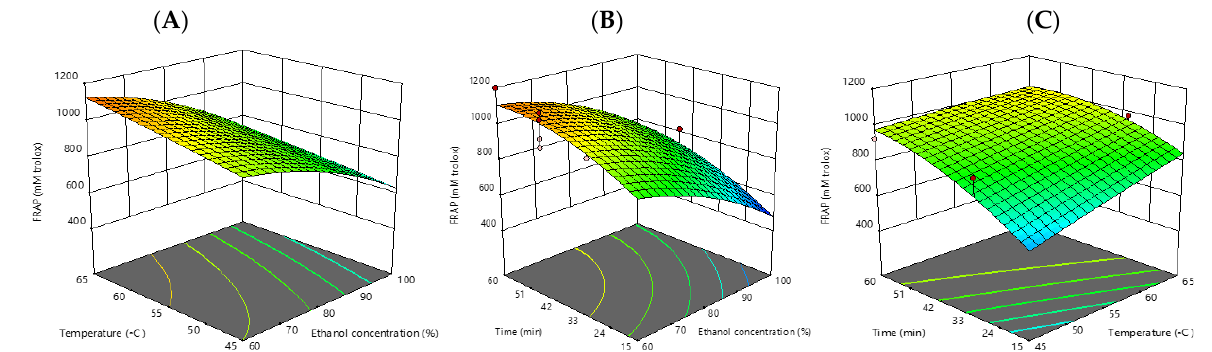
Figure 4. Response surface plots (3D) of antioxidant activity (FRAP assay) as a function of significant interaction between factors; ( A ) temperature and ethanol concentration; ( B ) time and ethanol concentration; ( C ) time and temperature of CSP extract. Table 5. Effects of encapsulation by spray-drying on quality properties of